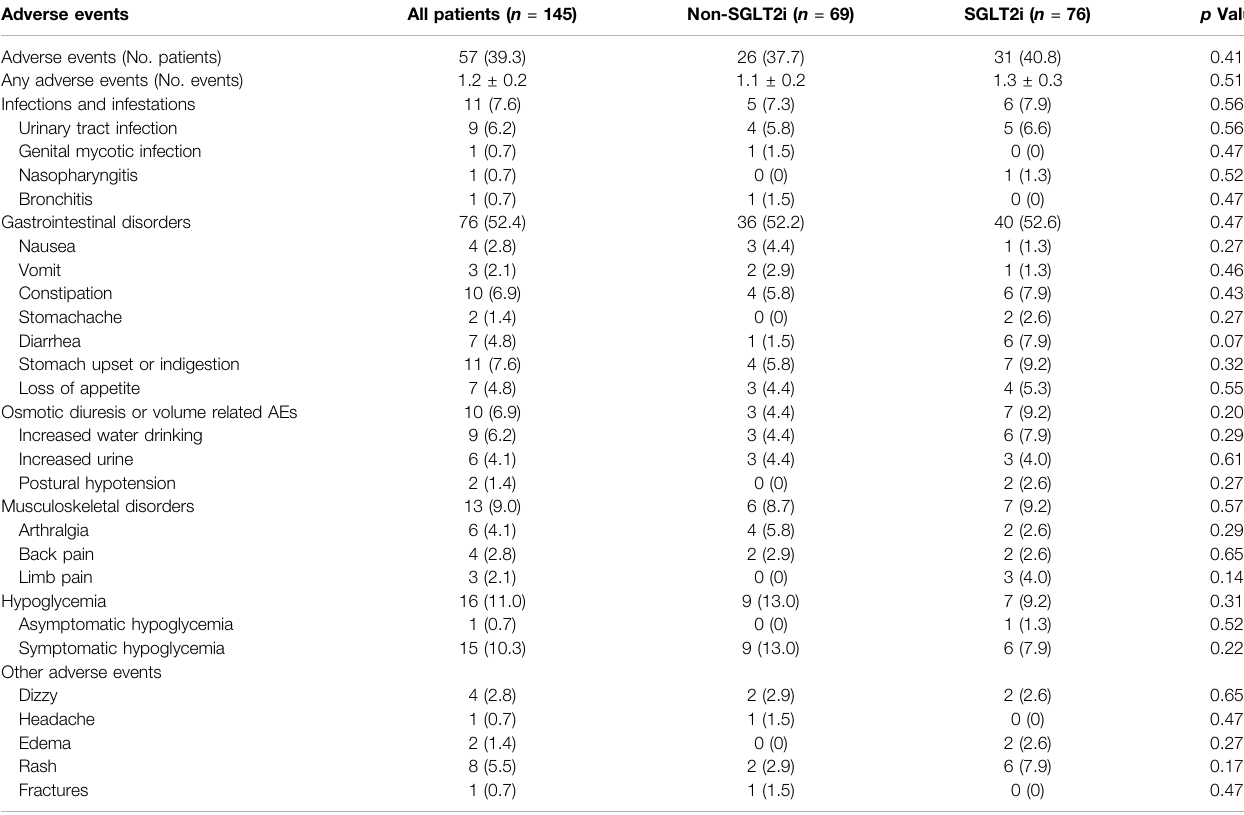
TABLE 5 | Adverse events. Adverse events All patients ( n = 145) Non-SGLT2i ( n = 69) Adverse events (No.